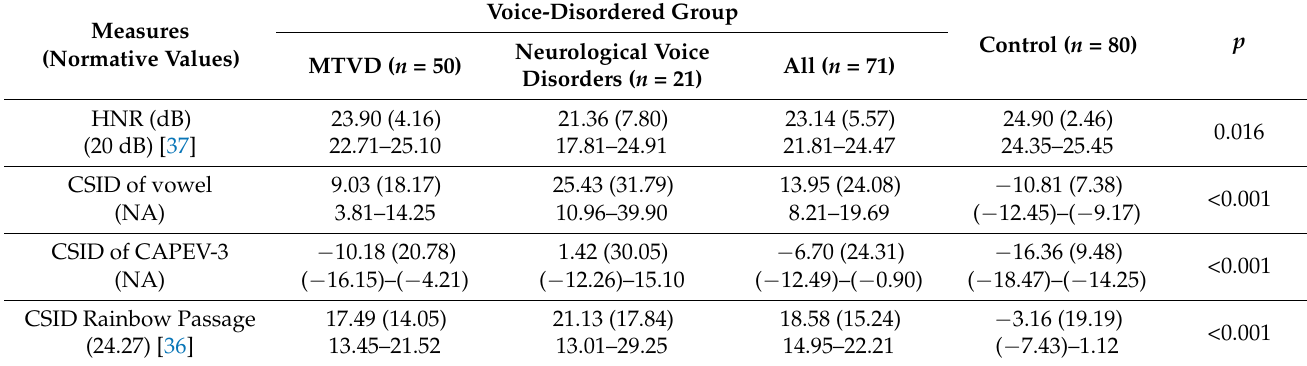
Table 2. Mean (SD) and 95% confidence intervals for the mean of voice data for voice-disordered and control groups. The p value indicates significance level of independent t -test comparisons of the voice- disordered group ( n = 71) and control group ( n = 80) for each measure. HNR: harmonics-to-noise ration; CSID: cepstral/spectral index of